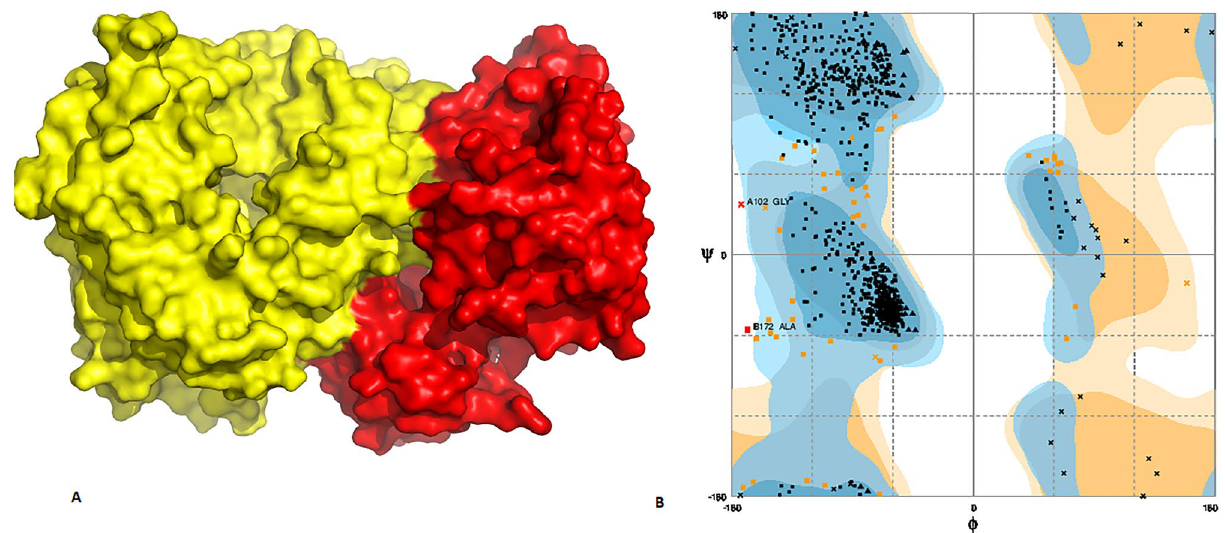
Figure 7. ( A ) Docked complex of HCV NS5B and p38 MAPK. Red color represents p38 MAPK while yellow signifies NS5B ( B ). Ramachandran plot shows allowed and disallowed